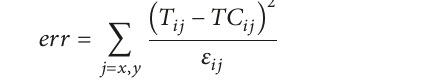
Figure 6: Comparison between observed (blue) and modeled (red) tilt vectors. Black tilt vectors are related to phase 1 and phase 2 evidenced in Figure 5 (see also Table 2).